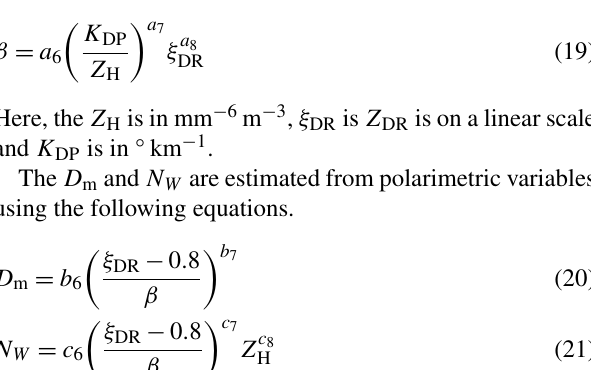
Table 3. Empirically derived coefficients of the D m – Z DR and N W – ( Z H ,D m ) relations for the PRE, SWM and NEM seasons and statis- tics of curve